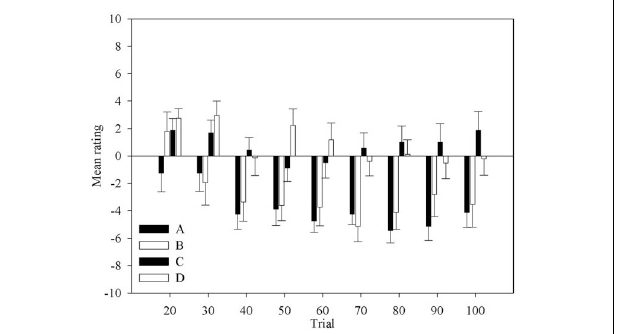
FIGURE 2 | Mean rating for each deck across question period. Error bars are the standard error of the mean.